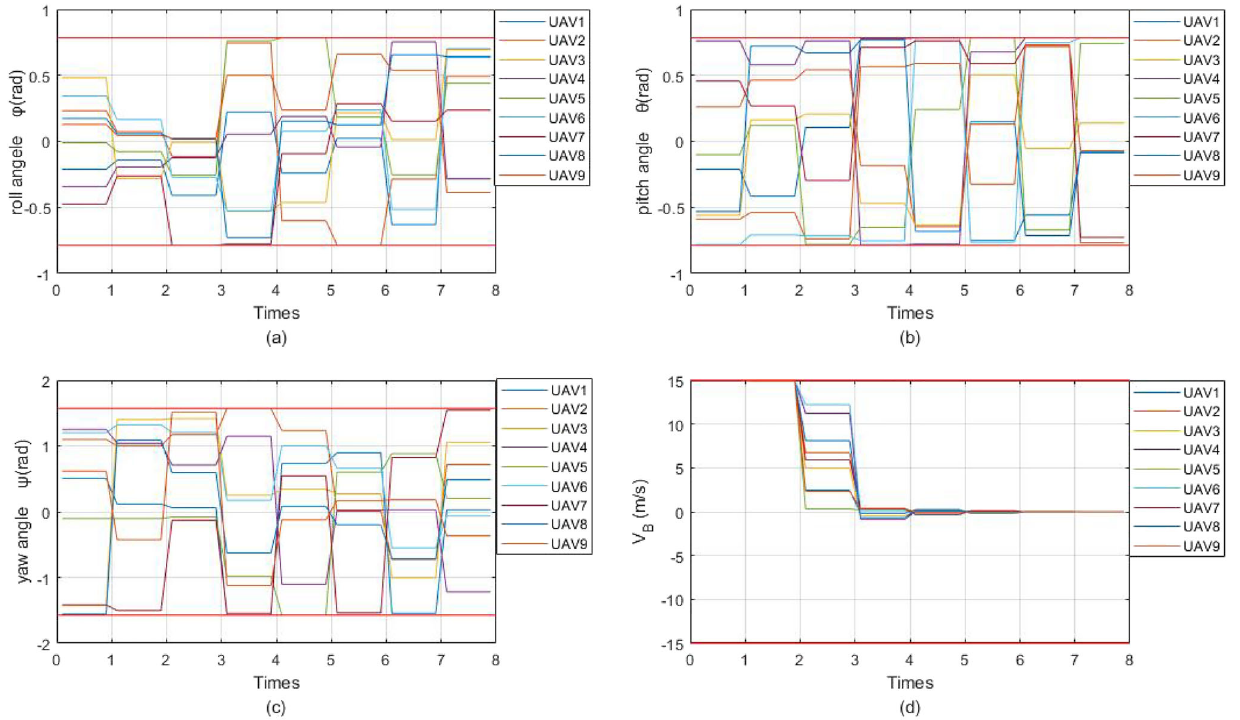
Fig. 16 Control inputs’ curve for each UAV at all